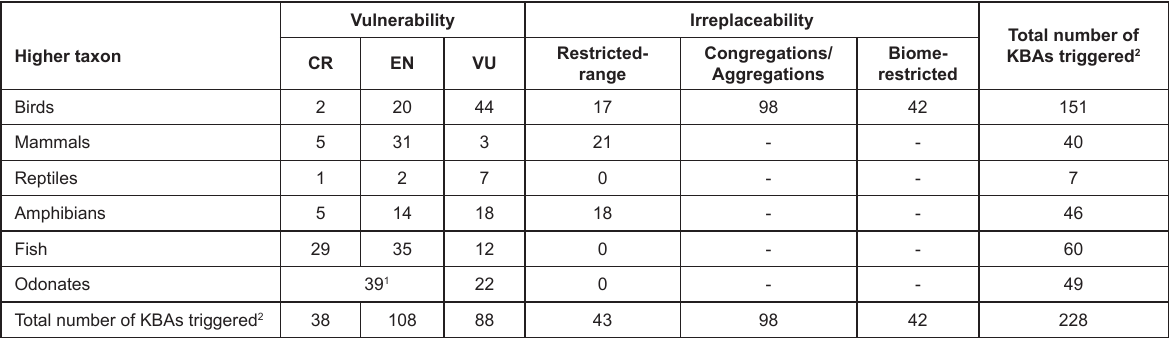
Table 4. Numbers of KBAs triggered by each of the criteria/subcriteria for each higher taxonomic group